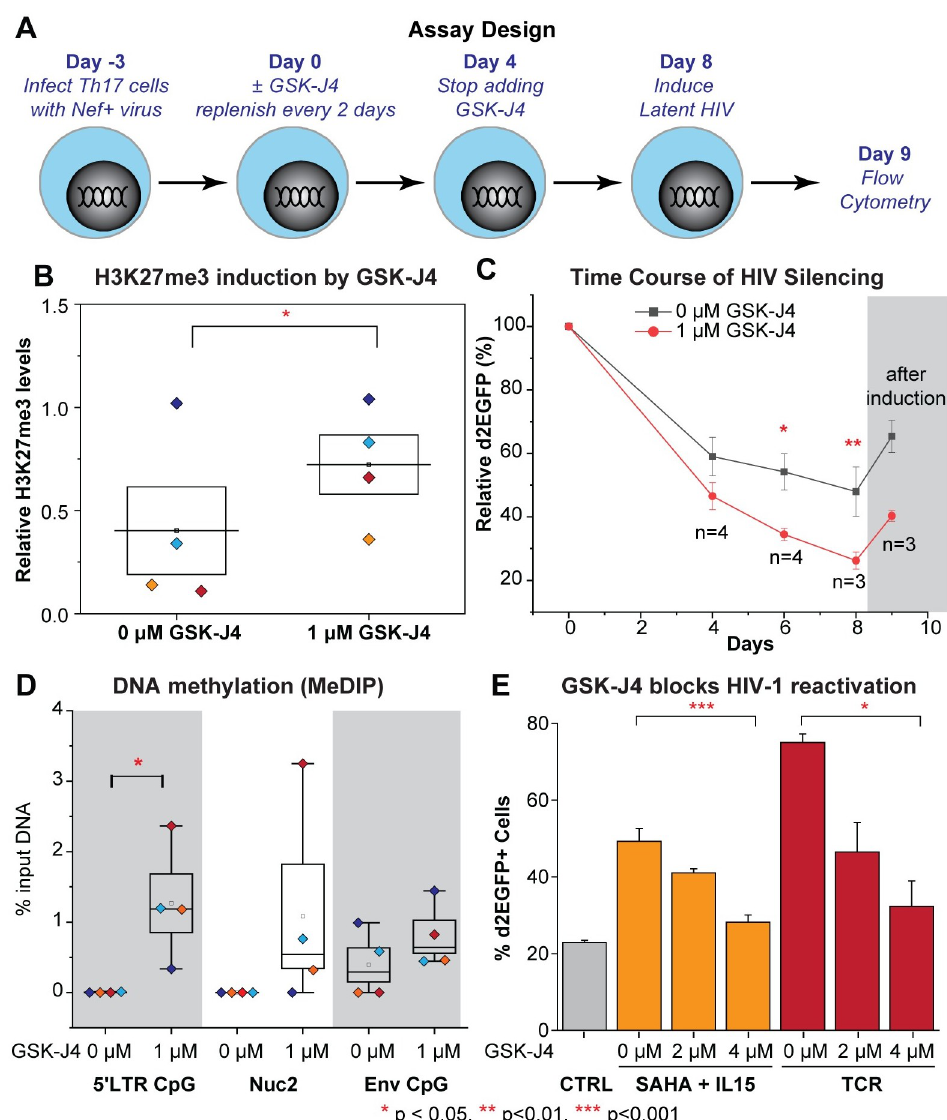
Fig 6. Inhibition of UTX by GSK-J4 promotes the silencing of HIV-1 in Th17 primary cells and elevates HIV-1 DNA methylation. (A) Schematic of experimental design. (B) Relative levels of H3K27me3 compared to histone H3 levels quantified from Western blot on treated Th17 cells from 4 donors at Day 4. One-tailed, paired t-test, � p < 0.05. (C) Silencing kinetics of HIV-1 in Th17 cells from 4 different donors in the presence of 0 μ M (vehicle) or 1 μ M of GSK-J4. Error bars: SEM of at least 3 separate biological replicates. Two-way ANOVA, Bonferroni posttests, � p < 0.05 �� p < 0.01. (D) MeDIP measuring the levels of methylated cytosine of HIV-1 at Day 4. Error bars: SEM of 4 different donors. One-tailed, paired t-test, n = 4, � p < 0.05. (E) GSK-J4 inhibits the reactivation of latent HIV-1 by SAHA & IL15 or TCR stimulation in Th17 primary cells. Cells were pretreated for 24 hours with GSK-J4, then further stimulated overnight with SAHA & IL15 or Human T-Activator CD3/CD28 Dynabeads with the ratio of 25 μ l of beads per 1 million cells. Quantification of HIV-1 reactivation under the indicated conditions. Note that only viable cells were chosen for HIV-1 reactivation measurement. Error bars: SEM of more than 3 separate replicates. One-way ANOVA, Bonferroni posttests n > 3.